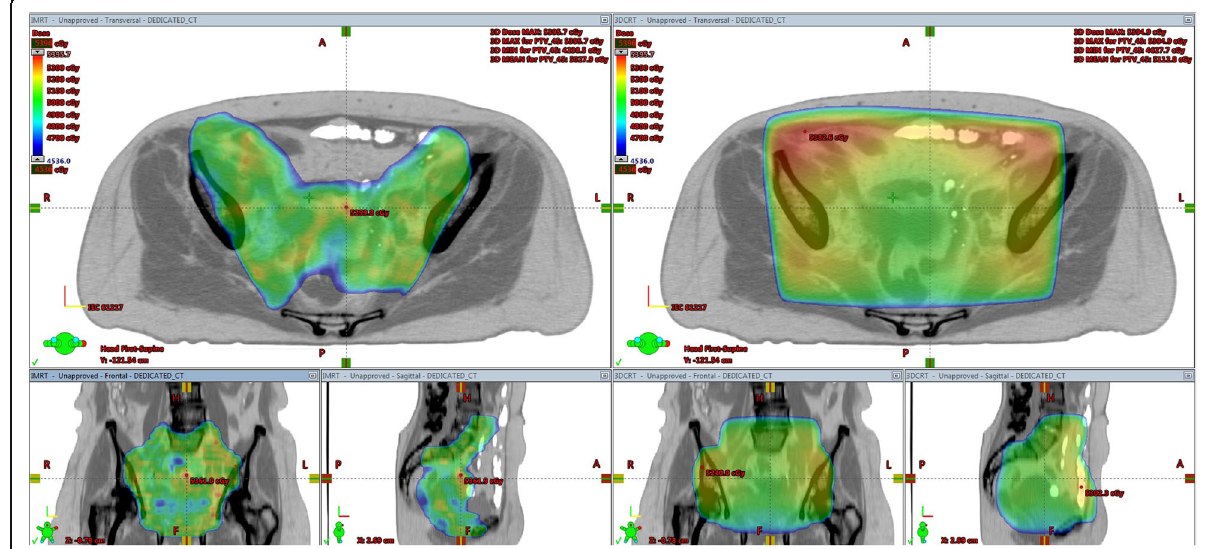
Fig. 1 The comparison of dose distribution between IMRT plan and 3DCRT